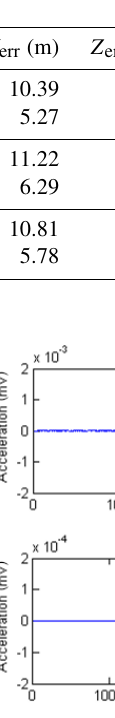
Table 5. Error comparison for the LSM algorithm and PSO algorithm.